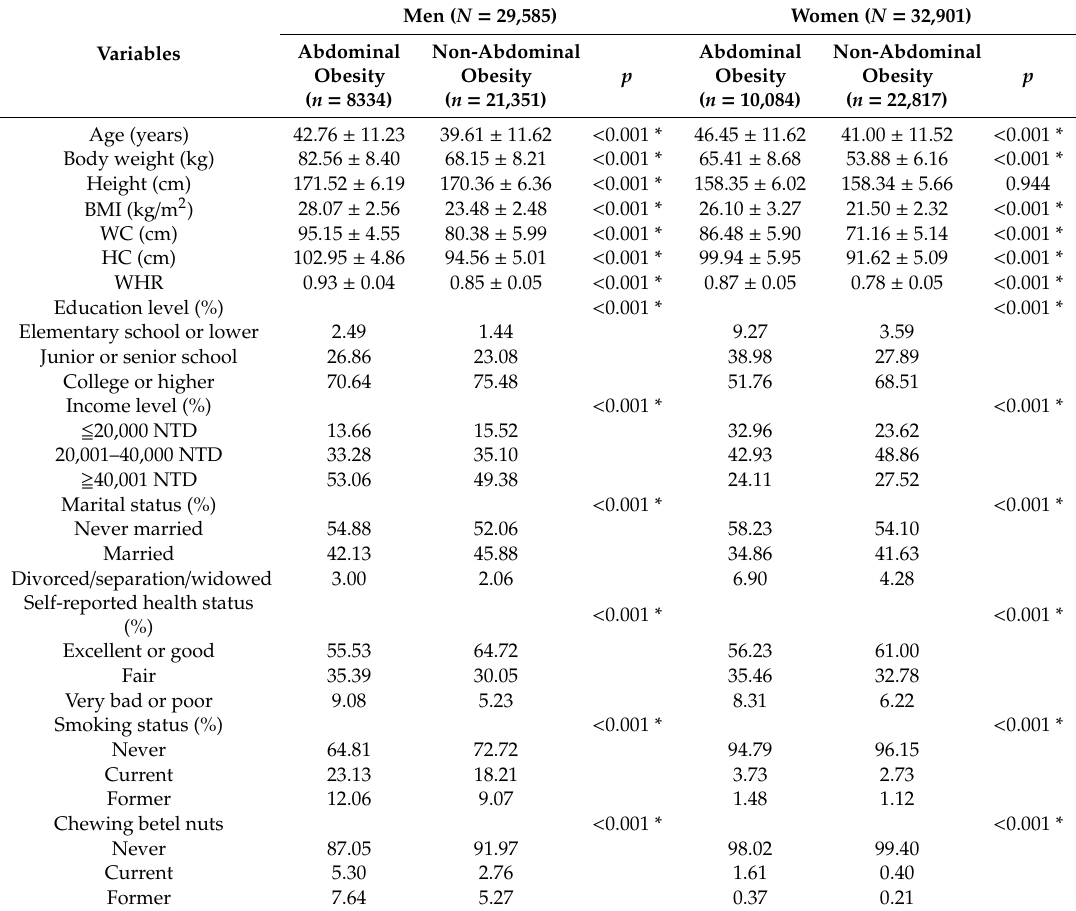
Table 1. Characteristics of the study participants with or without abdominal obesity among Taiwanese